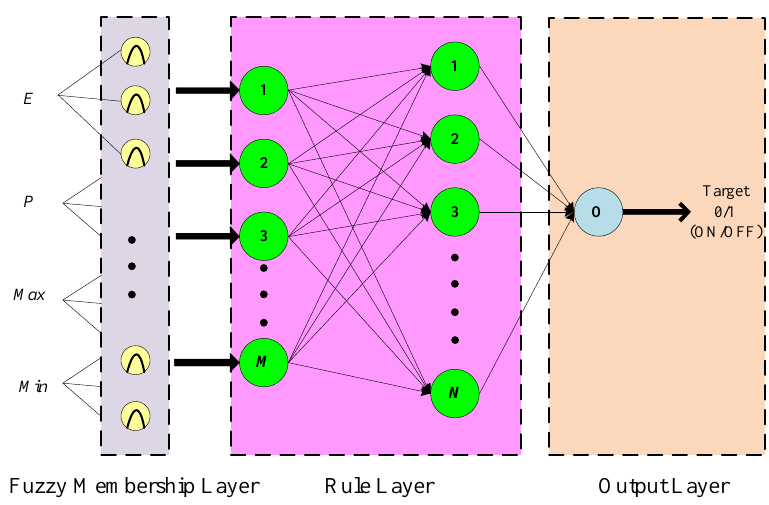
Figure 6. Structure of fuzzy neural network for disturbance identification.